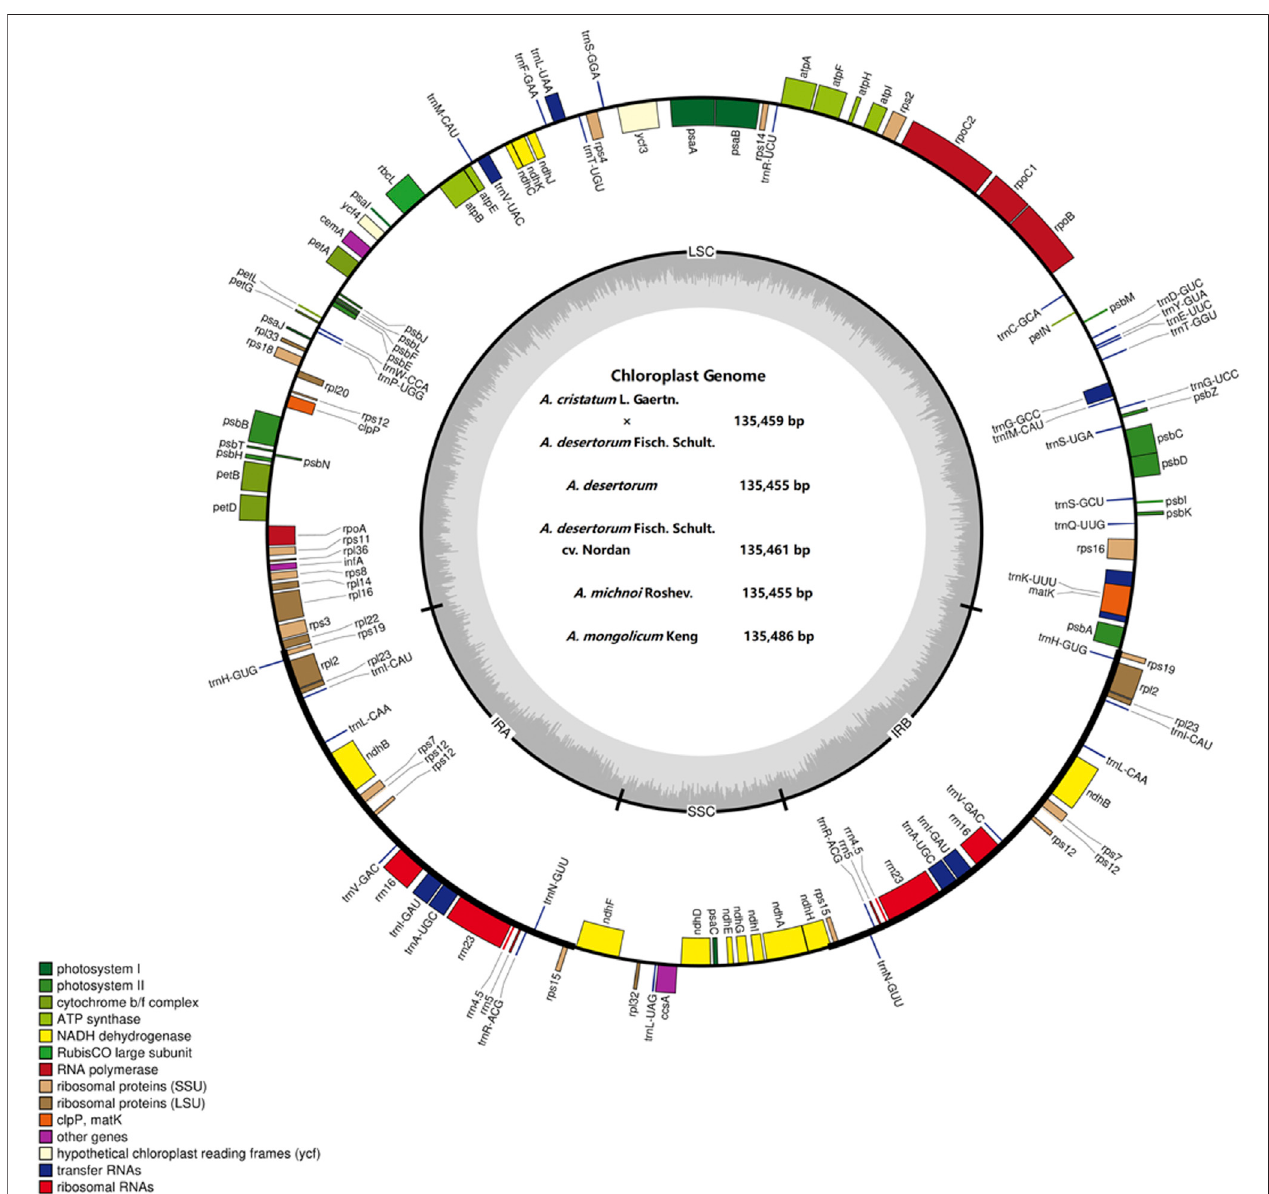
FIGURE 2 | Representative map of the Agropyron chloroplast genome. The plus encoding gene is on the outside of the circle, and the minus encoding gene is on the inside of the circle. The inner gray circle represents the GC content.